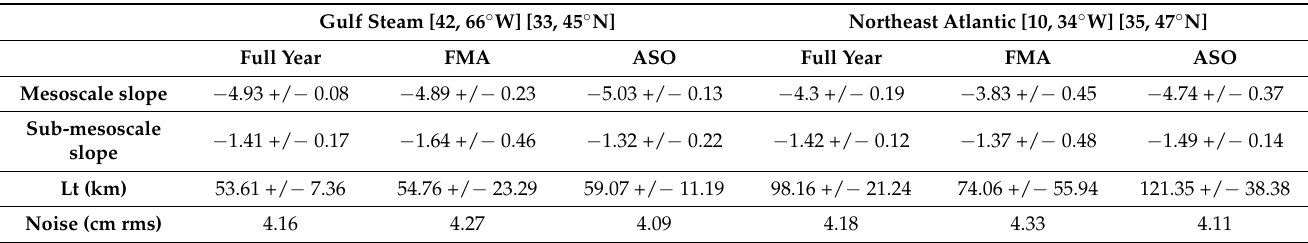
Table 5. Spectral parameters of S3A SLA signal over the Gulf Stream and northeast Atlantic regions. Mean spectral characteristics over one year and over winter (JFM) and summer (ASO) seasons. Measurement over years 2017–2018 were used for these